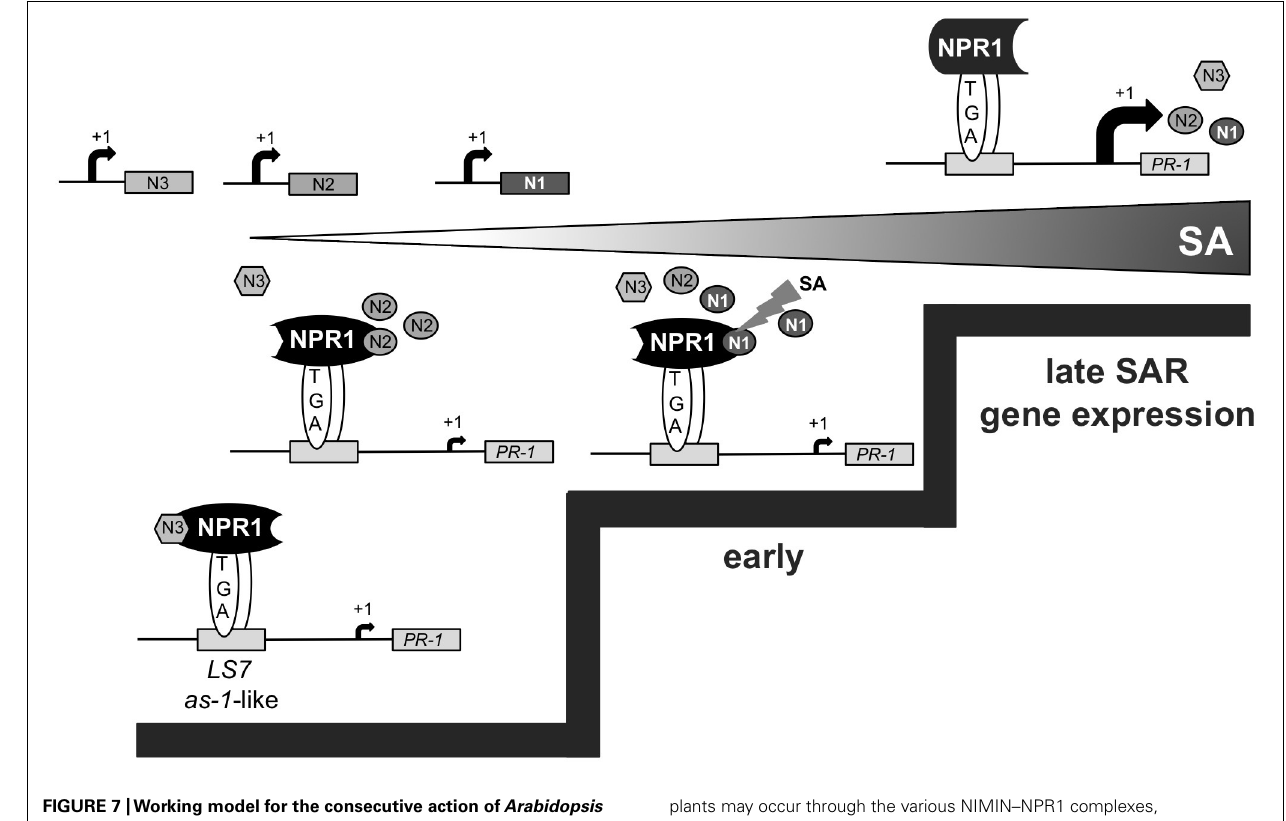
plants may occur through the various NIMIN–NPR1 complexes, enabling activation of PR genes at distinct threshold levels of SA (indicated by steps). In this scenario, the defense gene PR-1 is induced late during SAR by direct action of SA on the NIMIN1–NPR1 regulatory